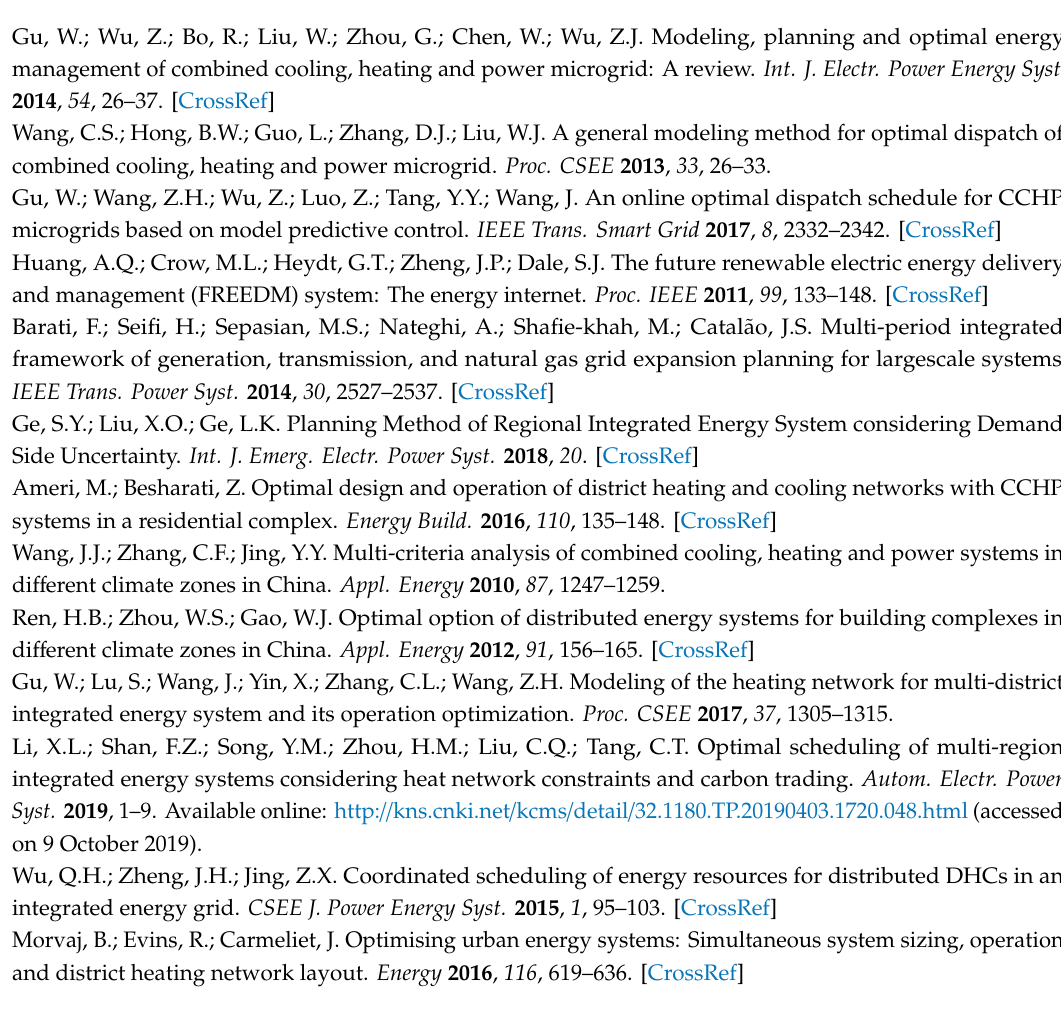
Figure A1. Outside Figure A1. Outside temperature.